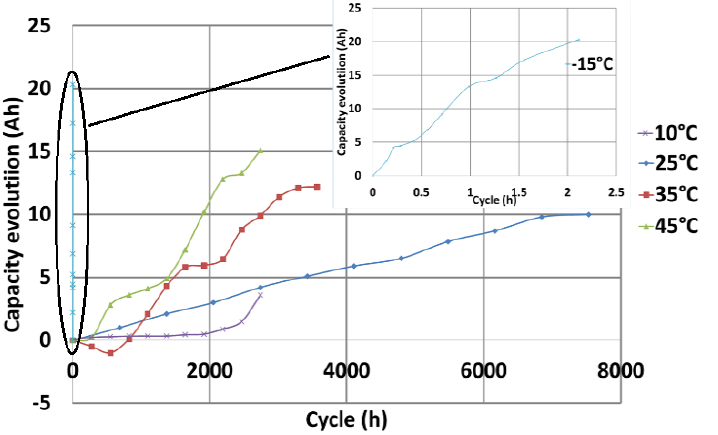
Figure 4. Capacity evolution of the NMC cell based on a combined calendar and cycling aging models at various